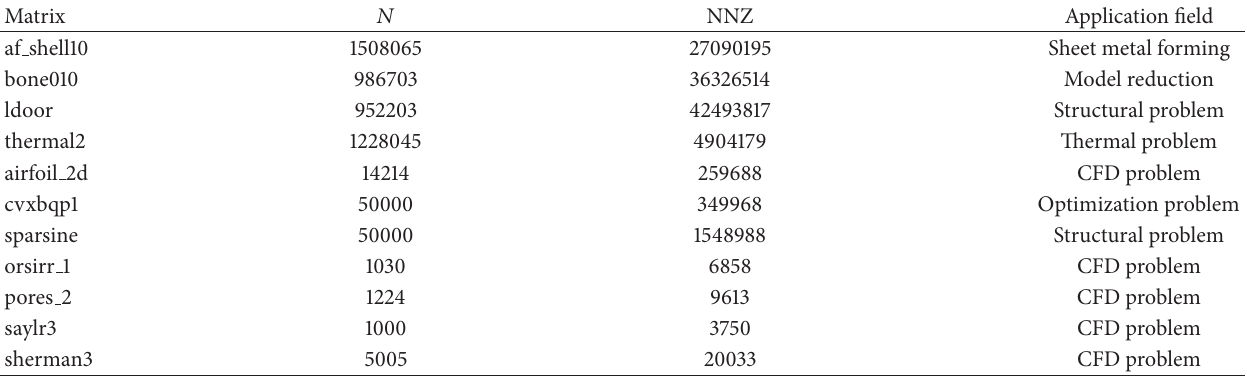
Table 1: Dimension ( 𝑁 ) and number of nonzero (NNZ) test matrices.